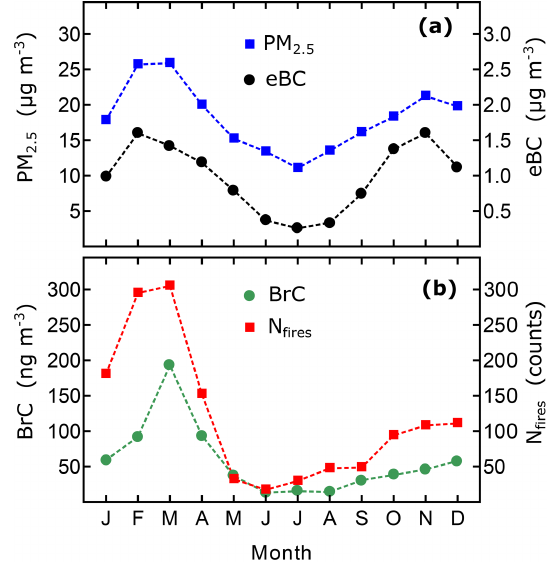
Figure 3. Monthly mean time series of Bogotá’s PM 2 . 5 (µgm − 3 ), equivalent black carbon (µgm − 3 ), brown carbon (µgm − 3 ), and fire counts. BrC and eBC are measured at the Monserrate site, while the PM 2 . 5 are observations from the air quality monitoring network. N f is the monthly mean of daily fire